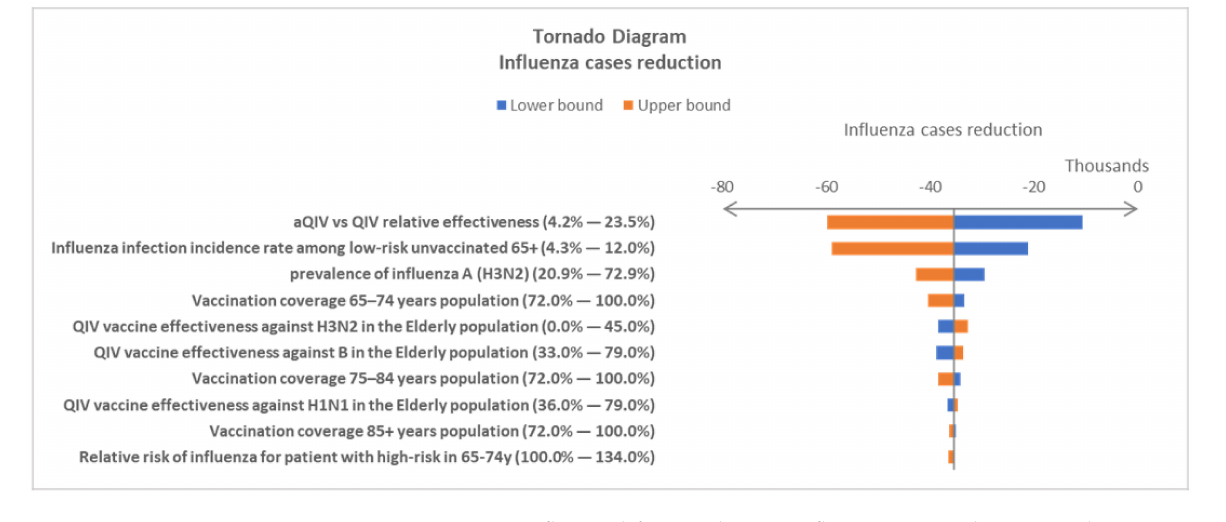
Figure 2. Top 10 most influential factors driving influenza case reduction in the comparison of adopting aQIV vs. QIV in the National Immunization Program (NIP) for the elderly population in South Korea. The values in parenthesis are the minimum and maximum values tested in the deterministic sensitivity analysis (DSA). aQIV—MF59 ® -adjuvanted quadrivalent influenza vaccine; QIV—standard quadrivalent influenza vaccine.